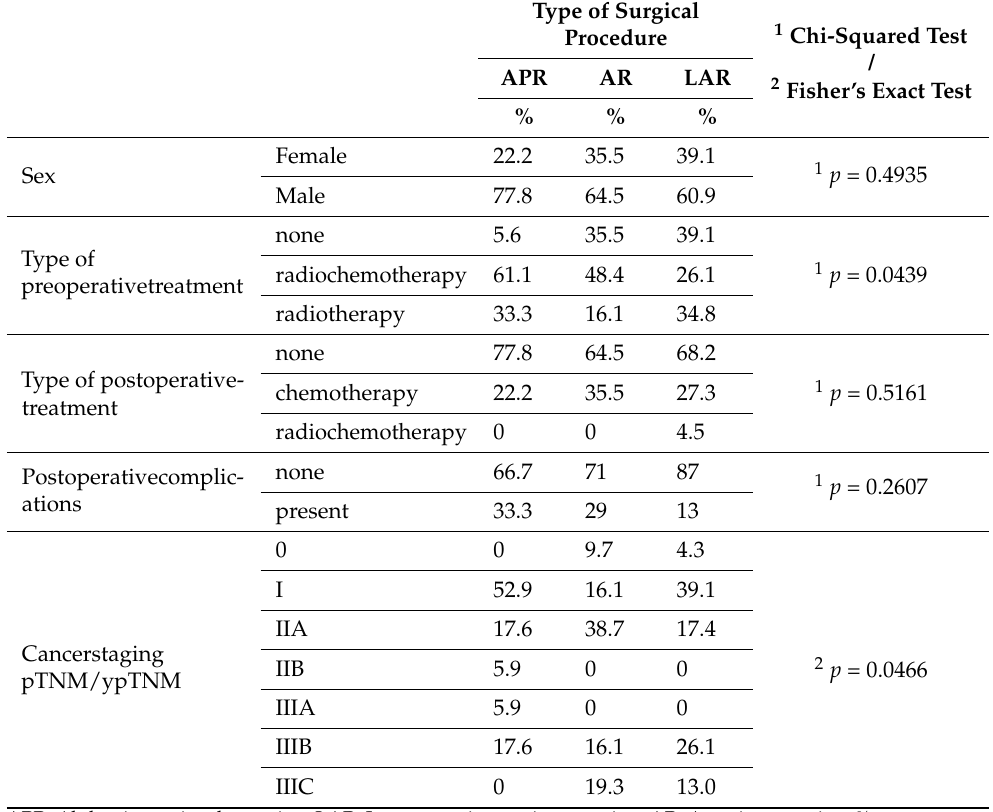
Table 2. Qualitative clinical data in the studied groups of patients (abdominoperineal resection, anterior resection and laparoscopic anterior resection) and the relationships between those